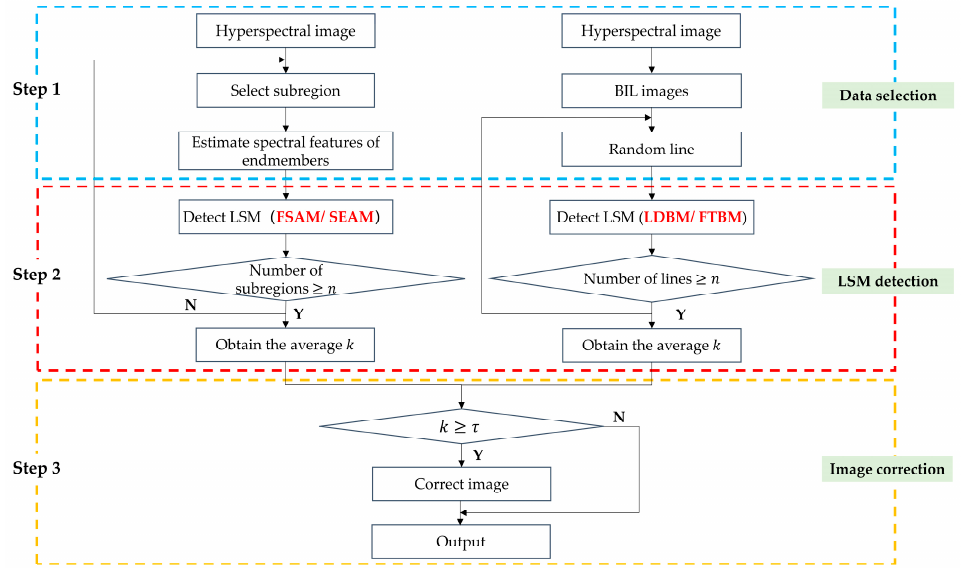
Figure 3. Flowchart of the proposed three-step strategy.